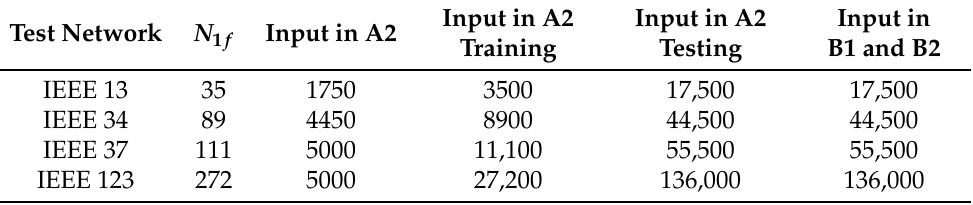
Table 2. Input dataset sizes used in the